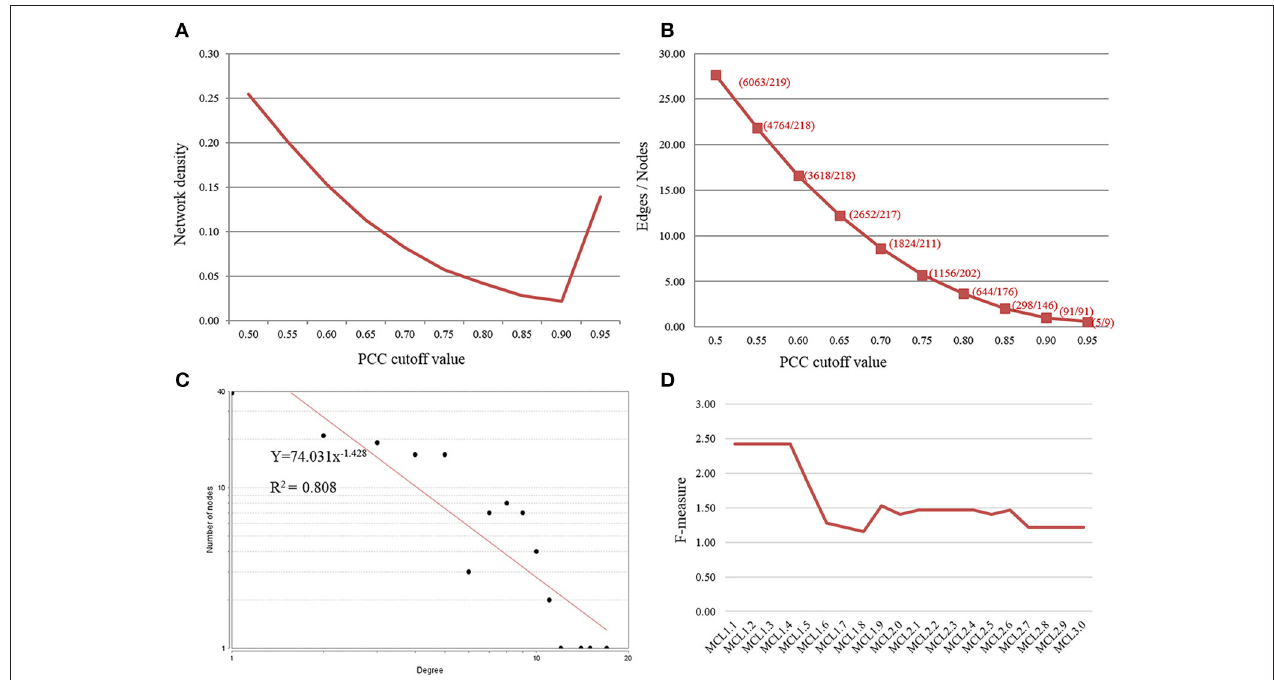
FIGURE 1 | Selection of Pearson correlation coefficient (PCC) threshold value. (A) Plot of number of edges and nodes vs. PCC threshold value. (B) Plot of Network density as a function of PCC threshold value. (C) Network satisfying scale-free topology showed the node degree distribution following power law ( R 2 > 0.8). (D) Parameter evaluation and optimization of the MCL inflation score ( I ) for cluster performance by F-measure.